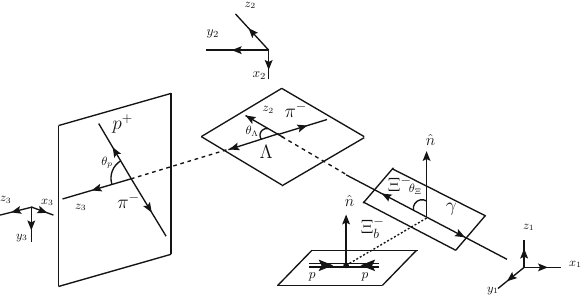
Fig. 2 Schematic view of the Ξ −